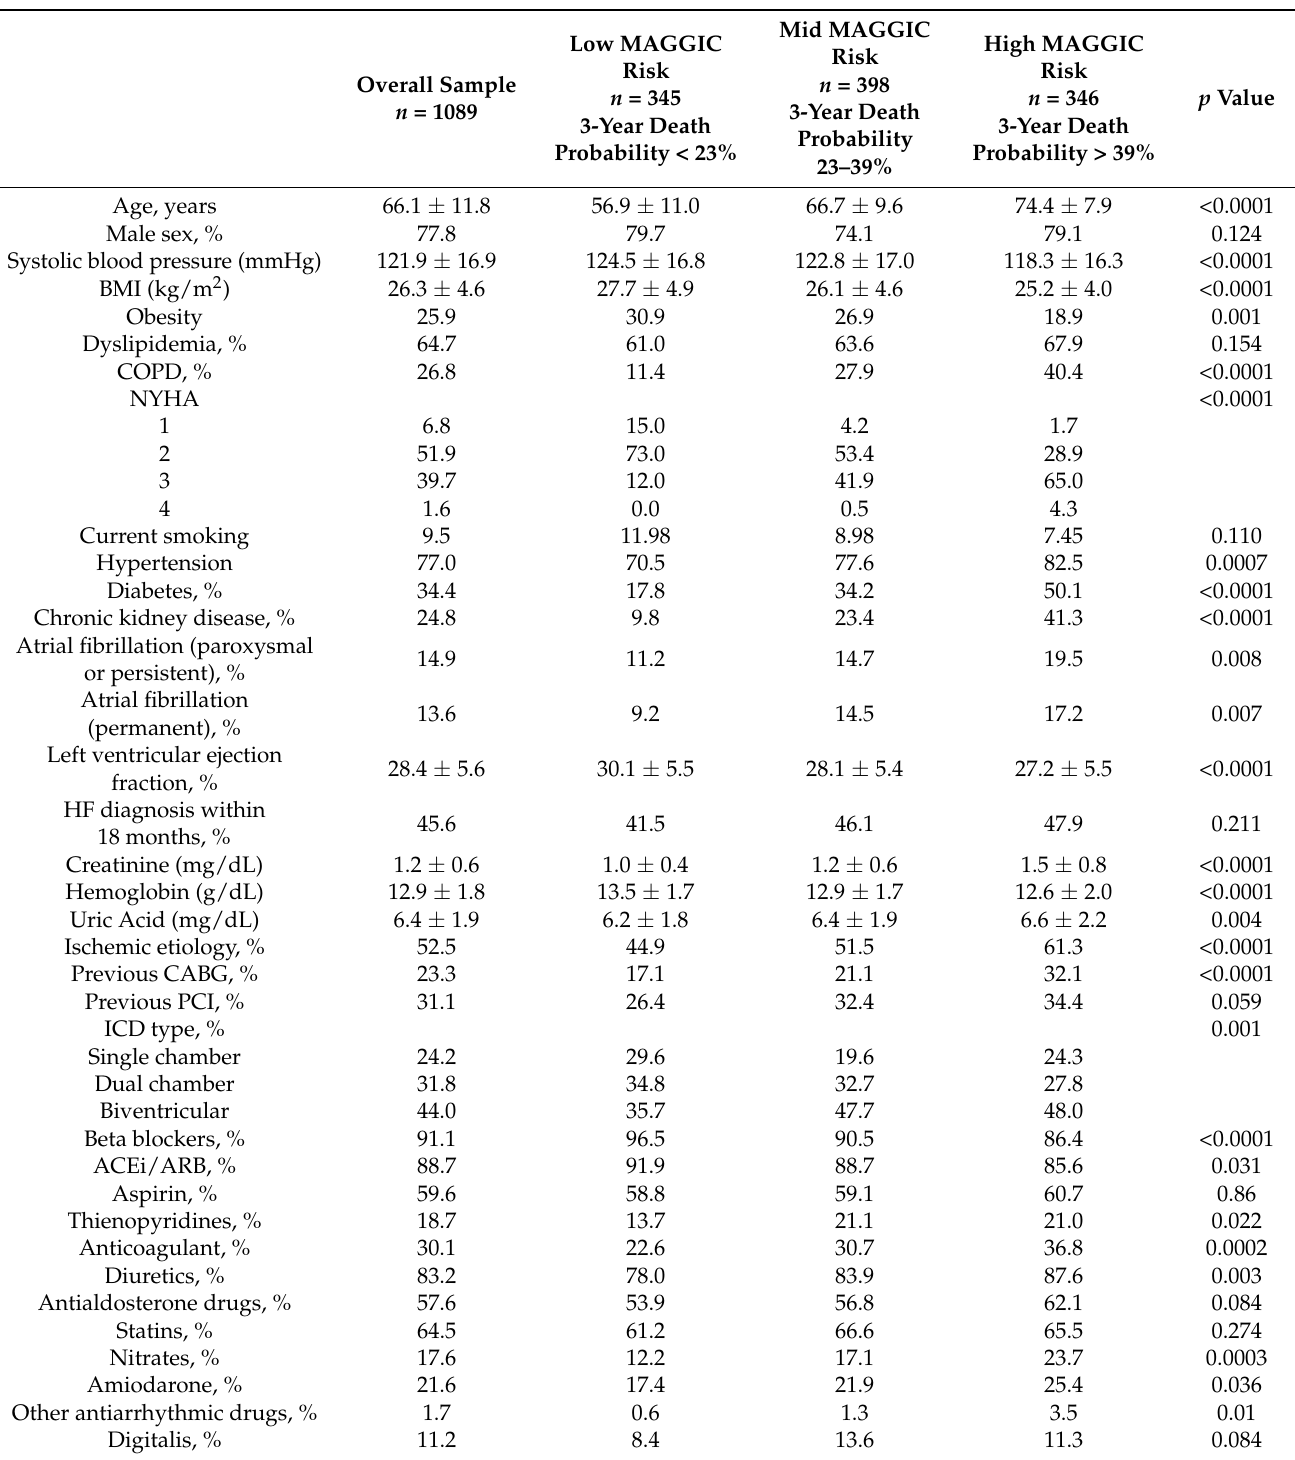
Table 1. General characteristics of the population at enrollment by categories of